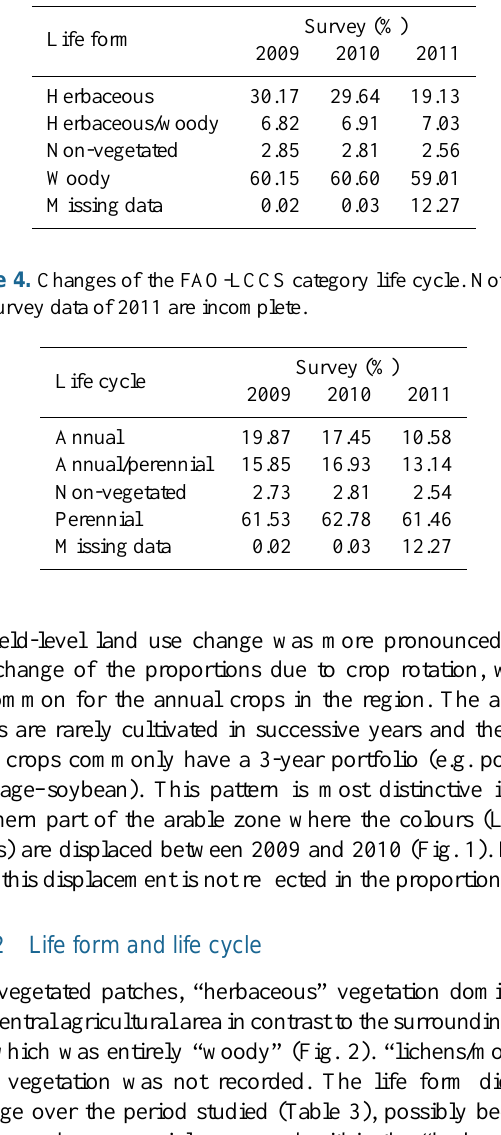
Table 3. Changes in the FAO-LCCS category life form. Note that the survey data of 2011 are incomplete.